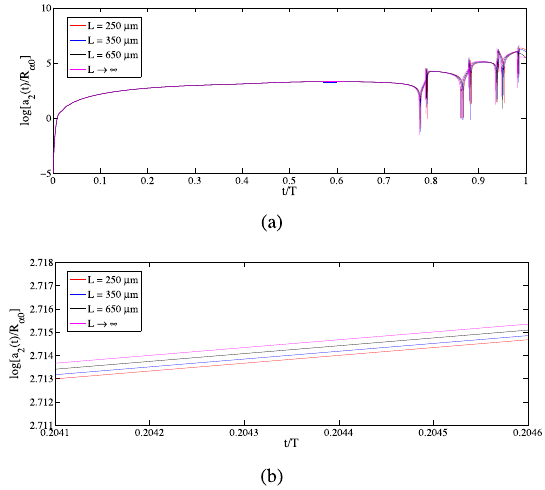
Figure 3. (a) Temporal evolution of a 2 ( t ) at different distances between bubble centers ( L ) ( T = 50 l s, R a 0 = 4.5 l m); (b) Partial enlarged detail of (a).